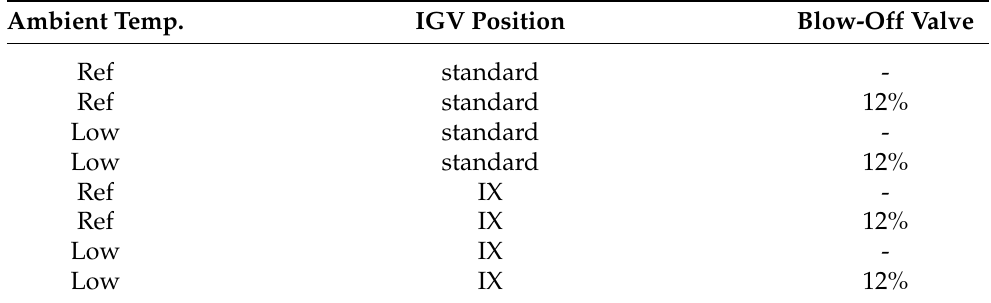
Table 2. Analyzed compressor operating